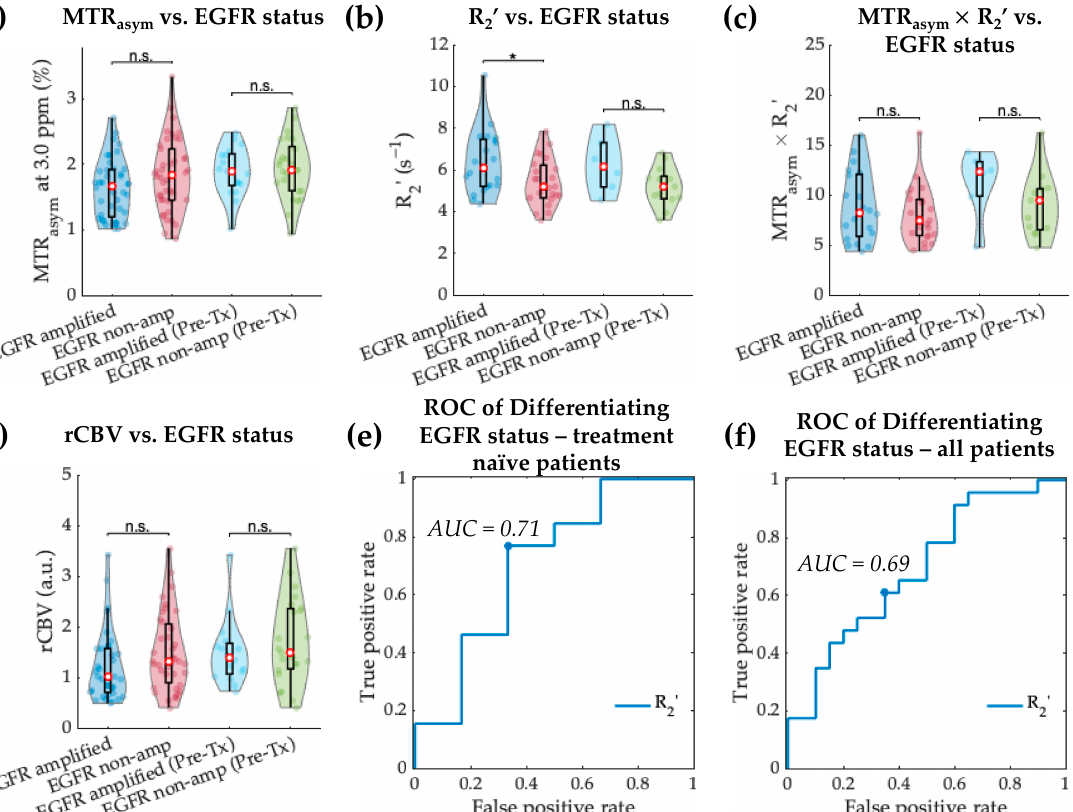
Figure 6. EGFR amplification status differentiation within IDH wild-type gliomas based on MTR asym , R 2 ’, MTR asym × R 2 ’, and rCBV. Violin plot graphs of IDH wild-type EGFR-amplified and non-amplified gliomas imaging features ( a – d ) are demonstrated for both the entire patient cohort and treatment-naïve patients. The red dots represent the median value, while the upper and lower edges of the box plots represent the 25th and 75th percentile values, respectively. The receiver operating characteristic curves for treatment-naïve patient cohort are plotted in ( e ), showing the best differentiation with R 2 ’ (AUC = 0.71). ROC curves in all patients are plotted in ( f ). *: p -value < 0.05; n.s.: non-significant.